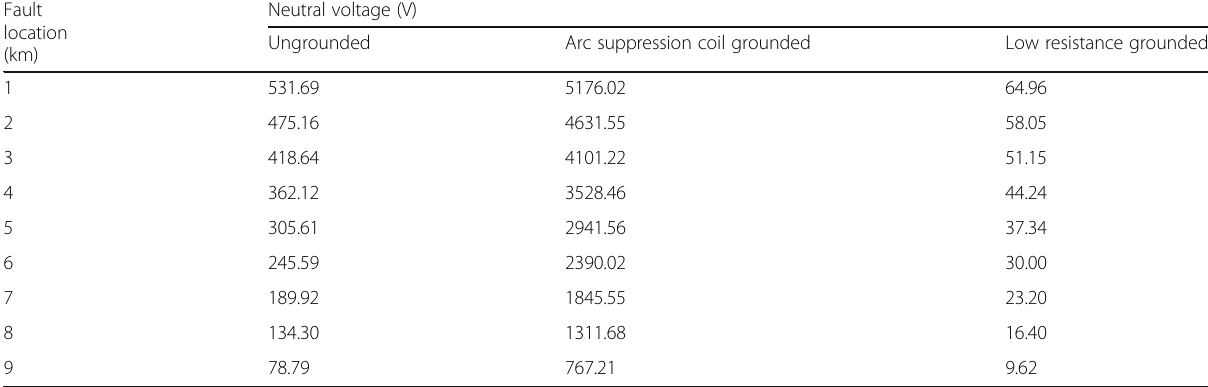
Table 2 Neutral voltage variation with fault location